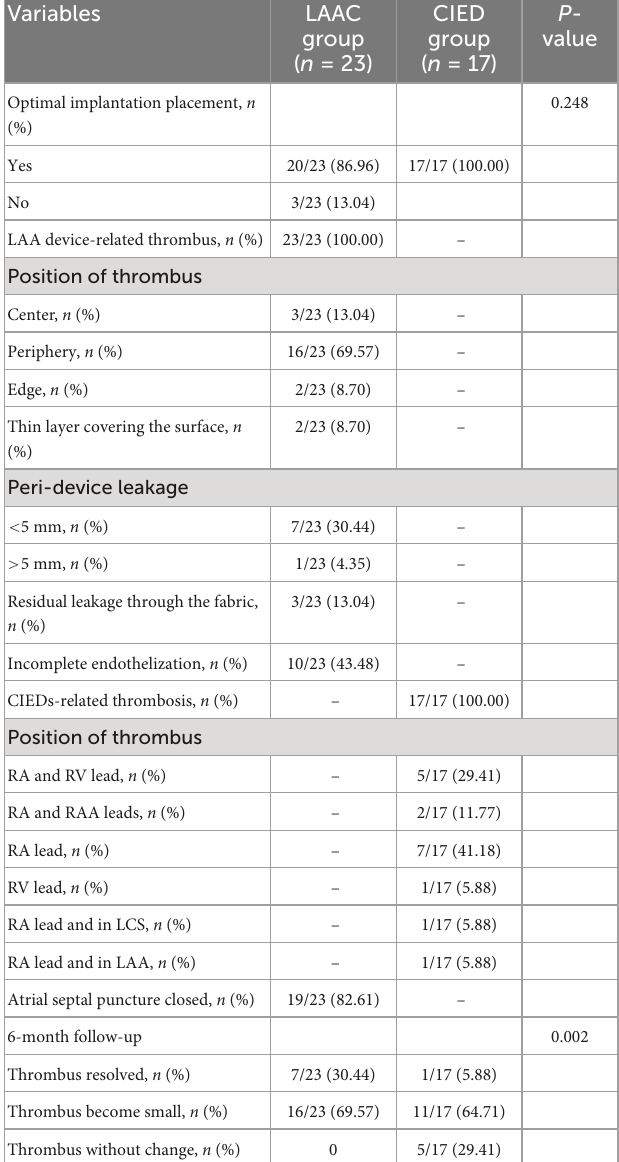
TABLE 2 Thrombus diagnosed by real time four-dimensional Transoesophageal echocardiography. Variables LAAC